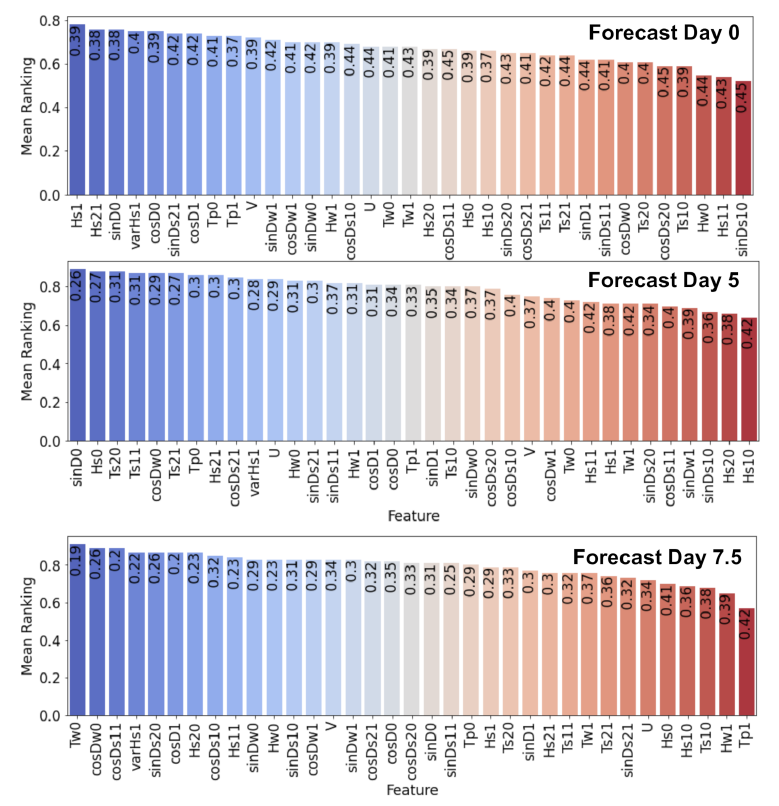
Figure 8. Final feature importance mean ranking in descending order. The blue colors indicate more important features for the random forest (RF) model, while the red colors point to less important variables. The values at the top of each bar correspond to the standard deviation of the feature’s ranking score. The three forecast times, 0, 5 and 7.5 days are indicated in the plots.